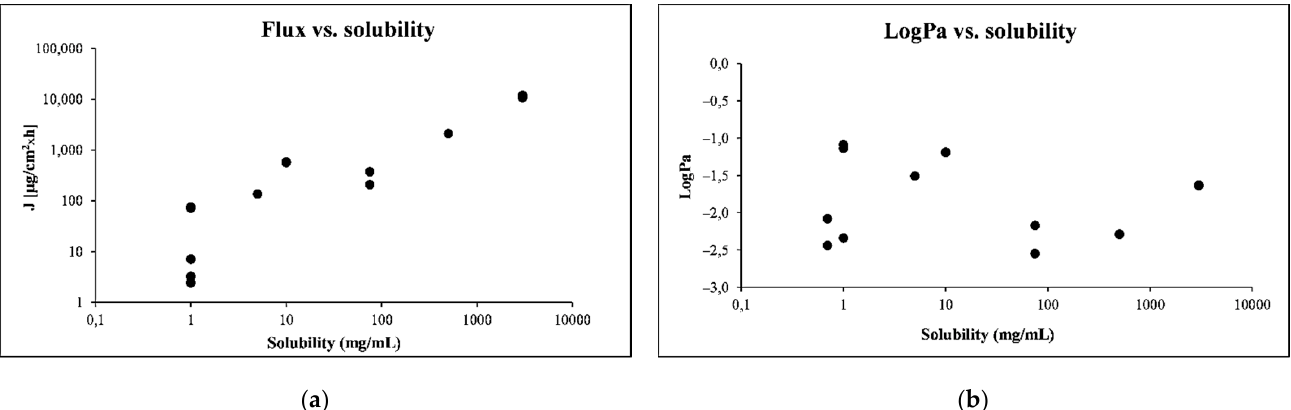
Figure 4. ( a ) Comparison of the solubility of PER with flux; ( b ) logP m . All values are mean.